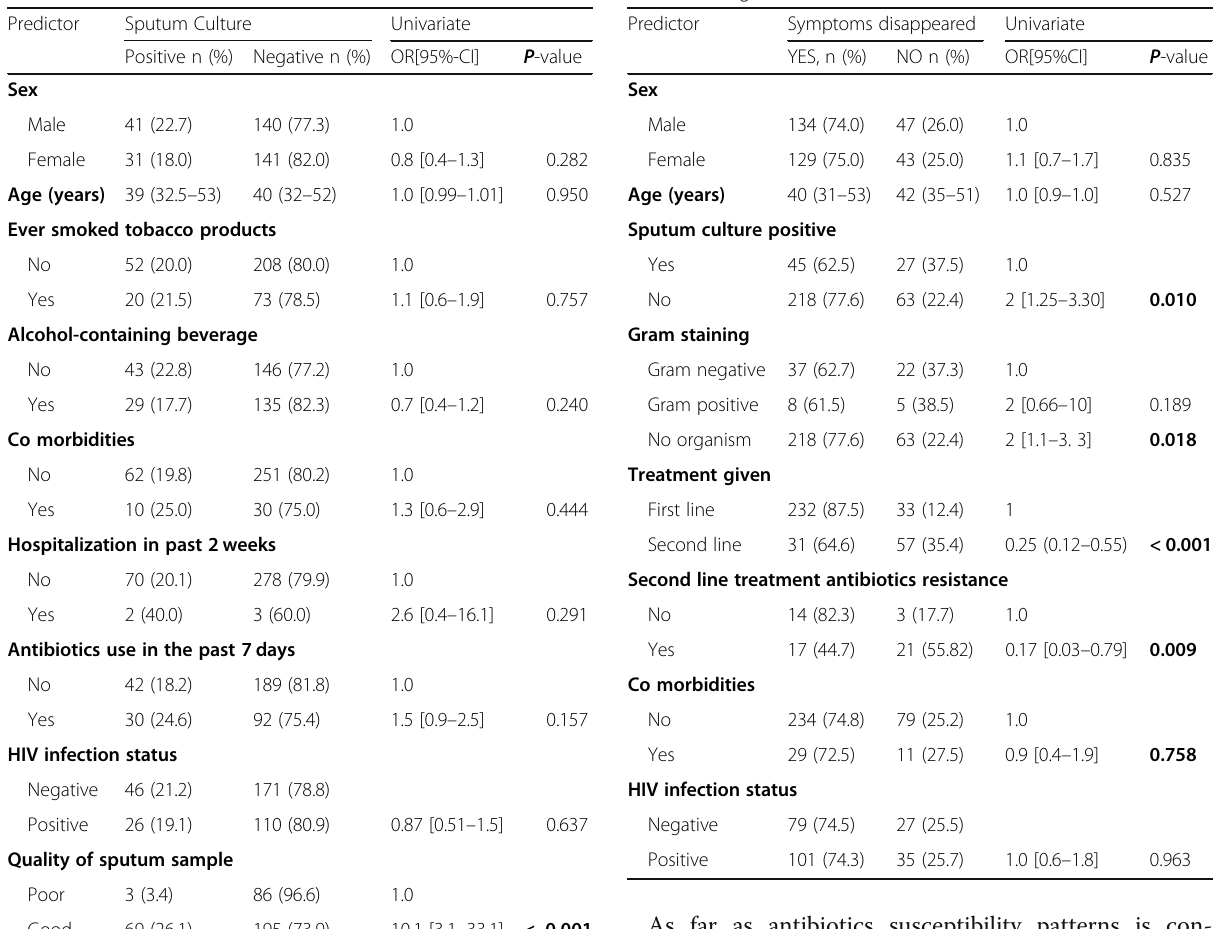
Table 5 Factors associated with symptoms disappearance after 14 days follow up of 353 adults ’ patients with pneumonia between August and December 2015 in Mwanza,